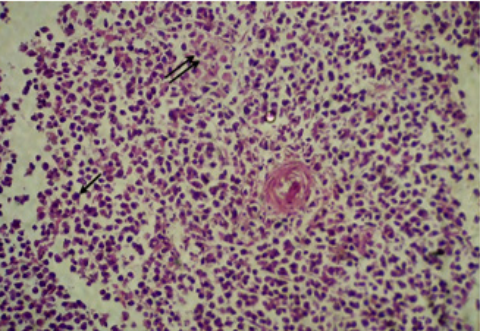
Figure 2: Photomicrograph showing lymphoid cells of various sizes. Lymphoblasts (arrow) and immature cells (double arrow) were prominent (× 400).